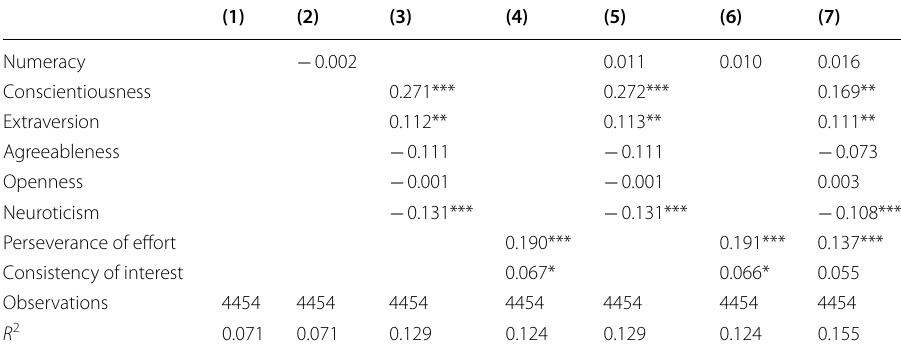
Table 8 Life satisfaction and cognitive and non-cognitive